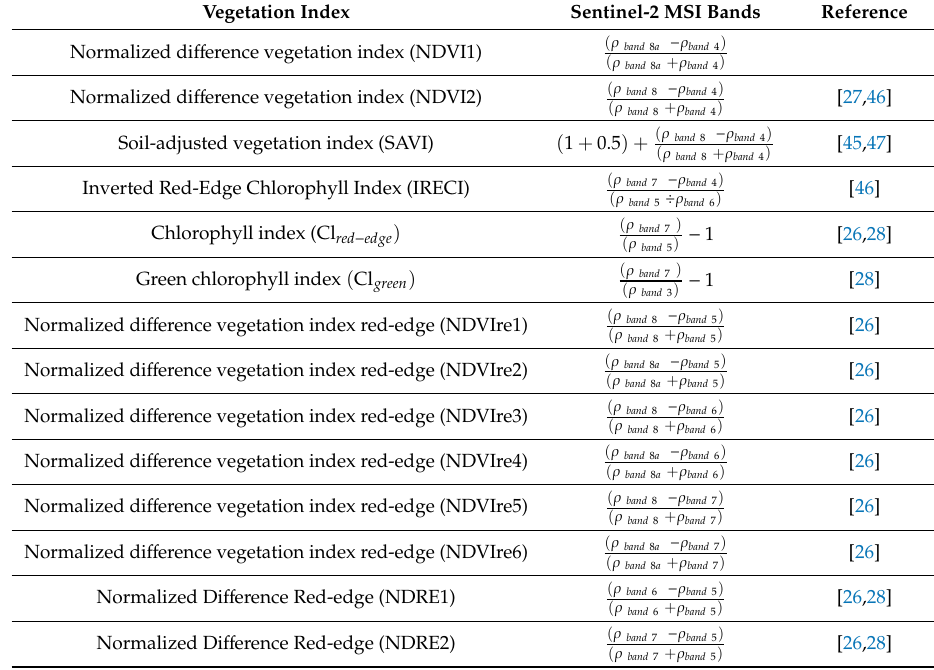
Table 2. Vegetation indices derived from the Sentinel-2 MSI (Multi-Spectral Instrument) spectral bands. Vegetation